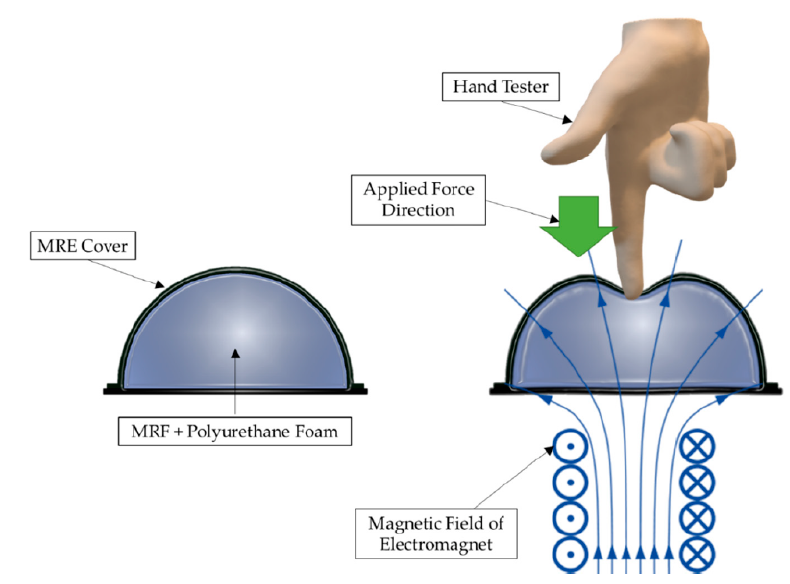
Figure 12. The example of haptic device (source: